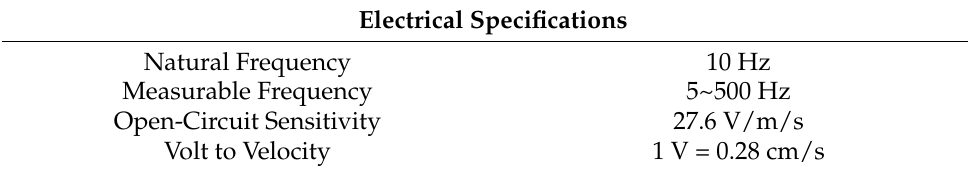
Table 3. Debris flow hazard history of Shenmu